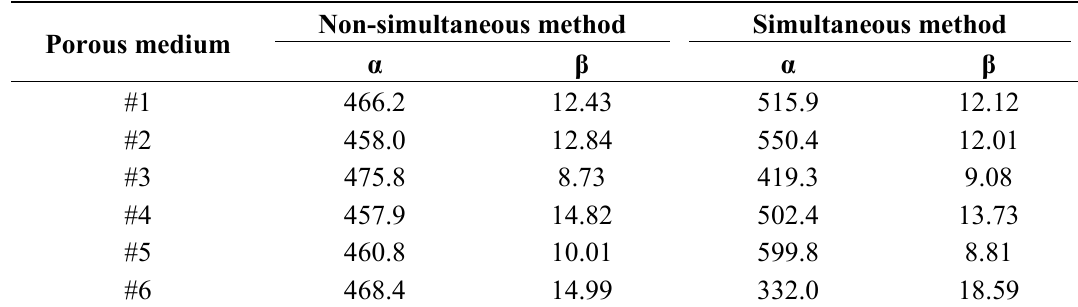
Table 2. Results of coefficients α and β using non-simultaneous and simultaneous